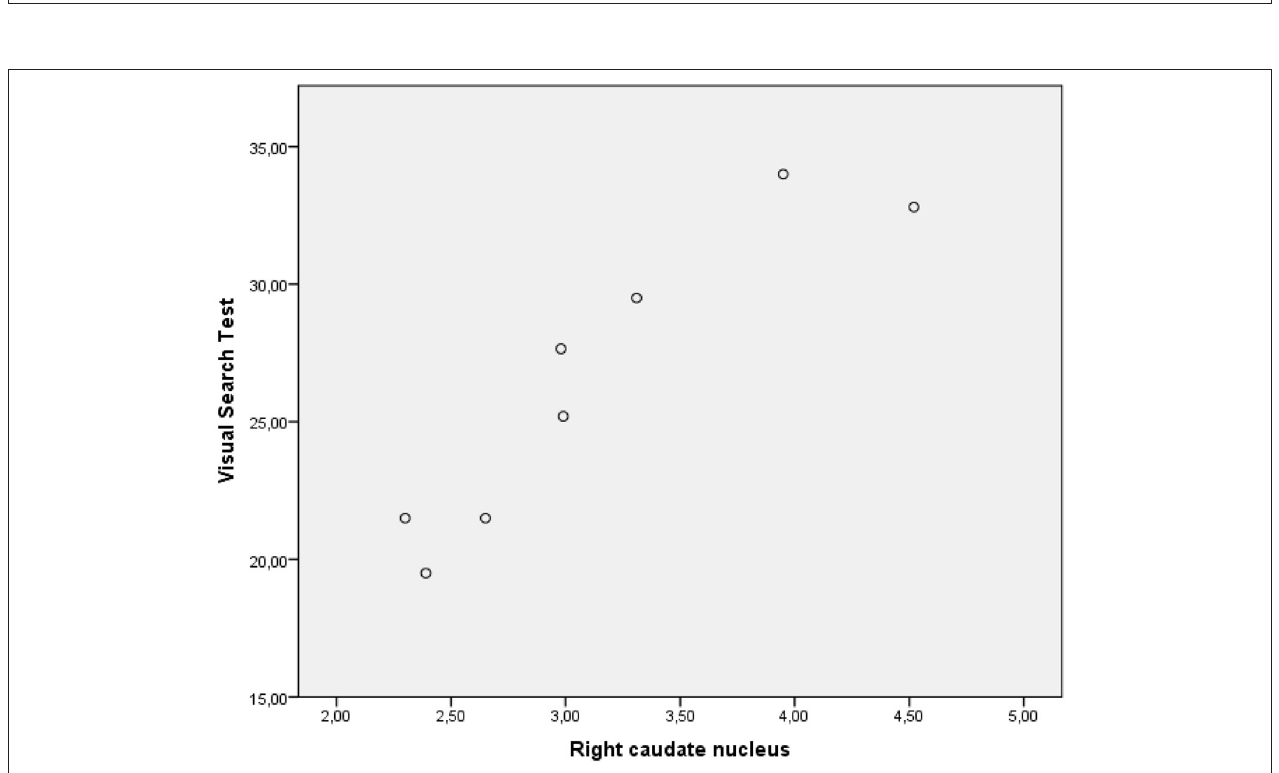
FIGURE 2 | Graphic representation of correlation between VST scores and 123I-FP-CIT binding in the right caudate nucleus (PD-MCI).